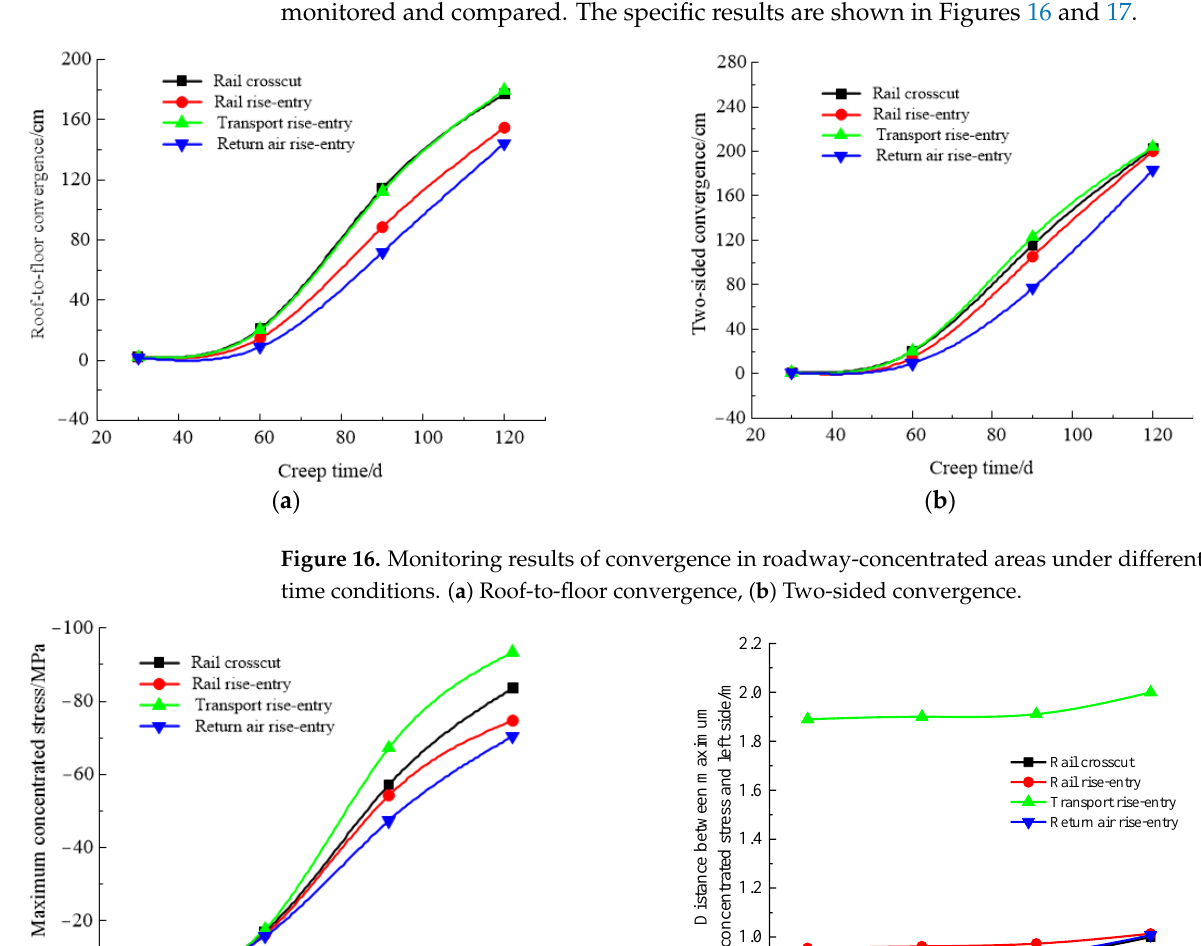
Figure 17. Maximum concentrated stress and its location monitoring results under different creep time conditions. ( a ) Maximum concentrated stress, ( b ) Position of maximum concentrated stress.